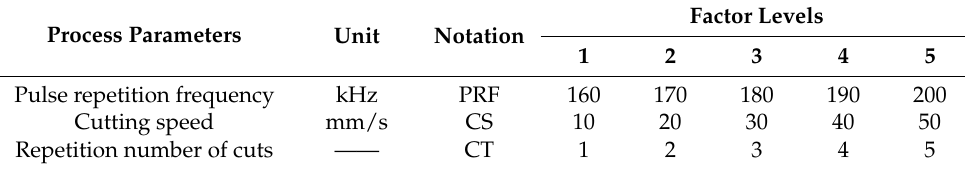
Table 2. Micro-cutting process parameters and levels.